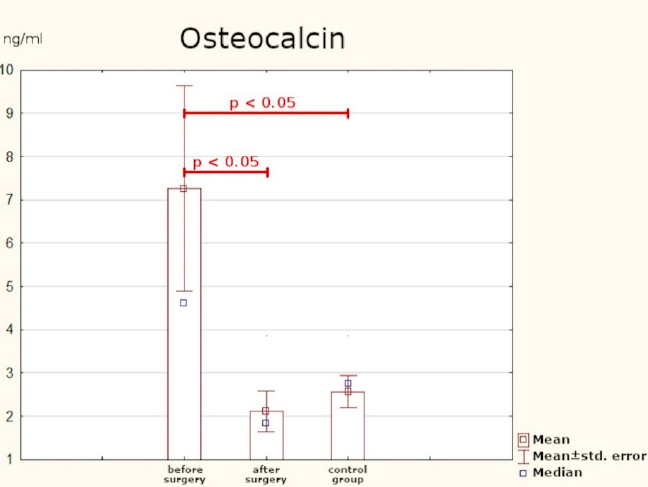
Figure 4. Serum concentrations of osteocalcin.